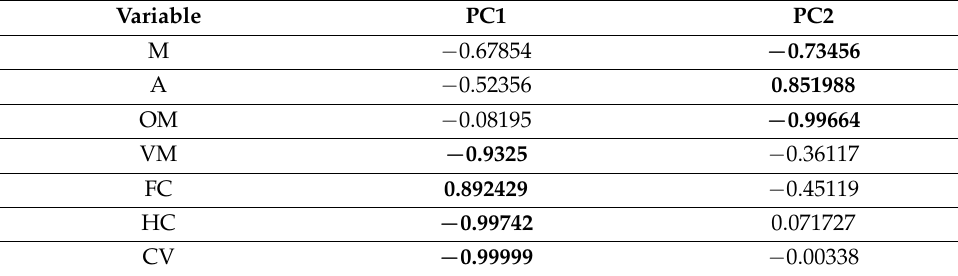
Table 4. Correlations of PCs and original